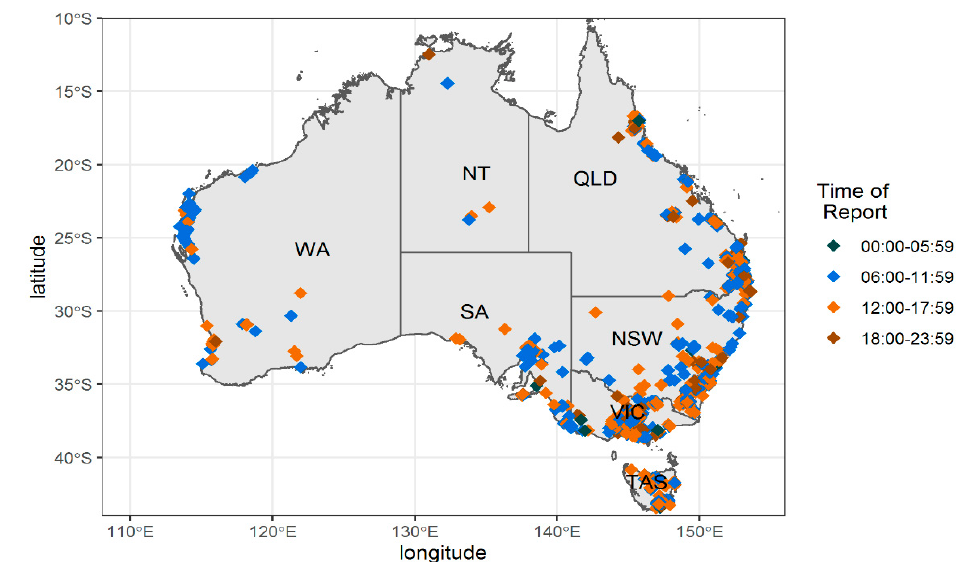
Figure 2. Location of roadkill reports by the quadrant of day (QOD), superimposed on a map of